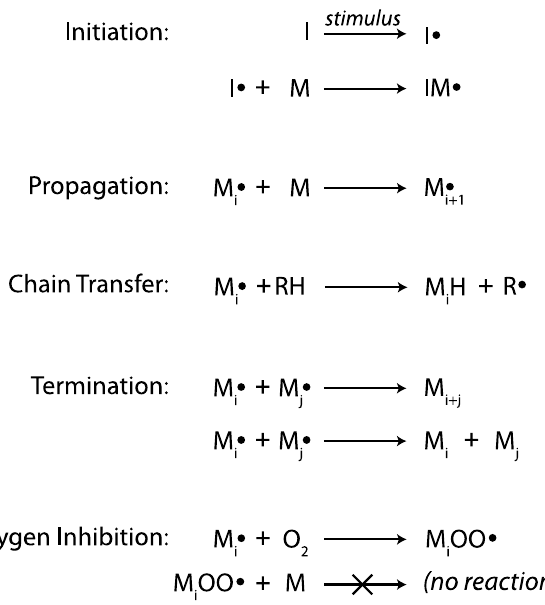
Figure 1. Chain-growth polymerization reactions [10–12]. I = an initiator, M = vinyl monomer, M i or M j = polymer with, i or j repeat units, respectively, O = oxygen, H = hydrogen, RH = a compound with a readily abstractable hydrogen, R = RH after hydrogen abstraction.